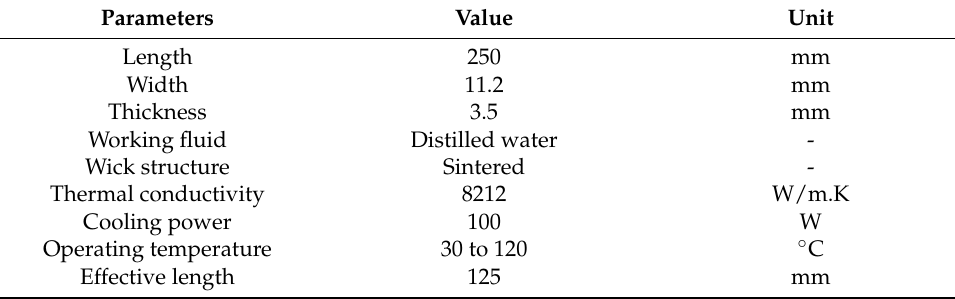
Figure 1. The prismatic 2300 F LiC cell and HPCS with the dimensions. Table 2. Thermo-physical properties of the utilized heat pipe.